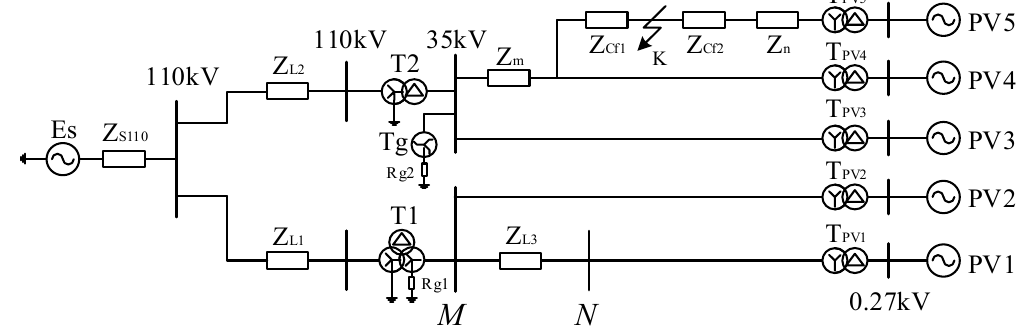
Figure 9. Equivalent circuit for the fault on the collector line in photovoltaic power station (PVPS) 3. The composite sequence network for a two-phase ground short-circuit obtained from the boundary conditions is shown in Figure 10.